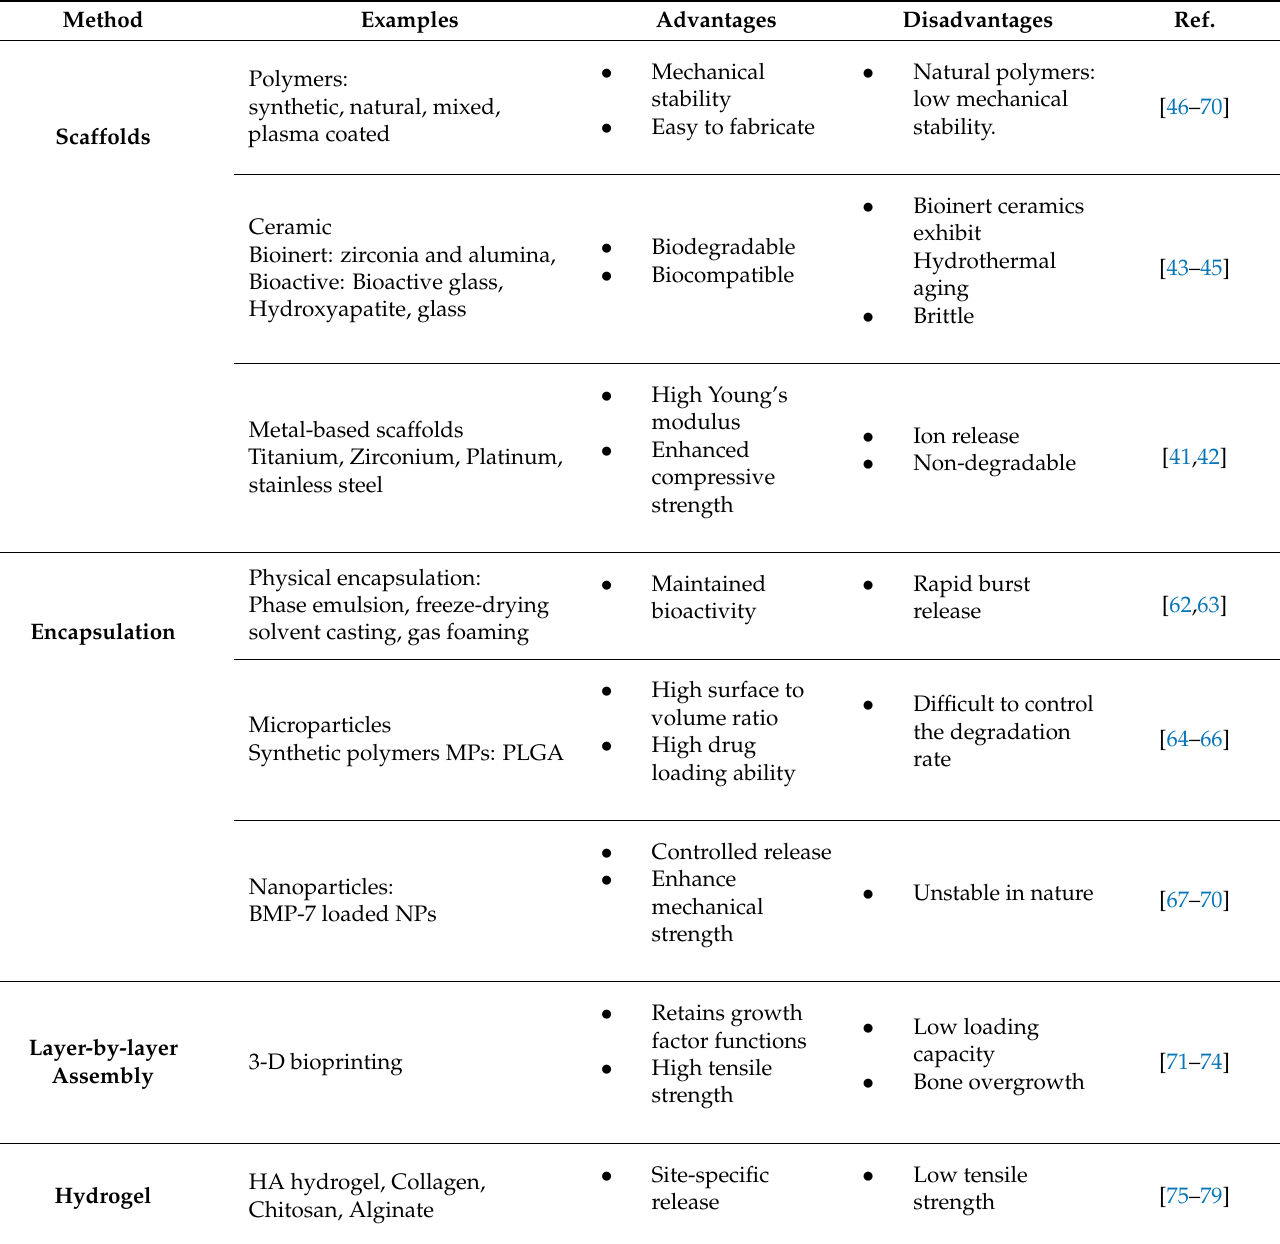
Table 2. Bioengineering methods of growth factor delivery, examples, advantages, and